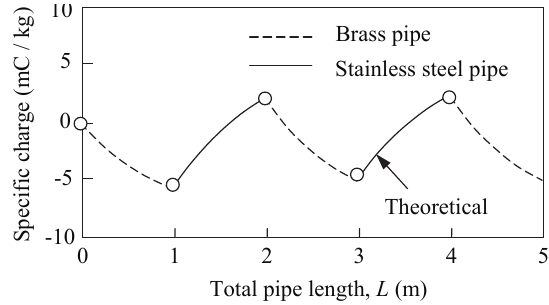
Fig. 3 Control of particle charging by a system com- bining two different pipe materials (alumina particles, count median diameter: 3.3 μ m, pipe diameter: 6 mm, air velocity: 40 m/s, mass flow ratio: 5 × 10 − 4 kg-particle/kg-air).